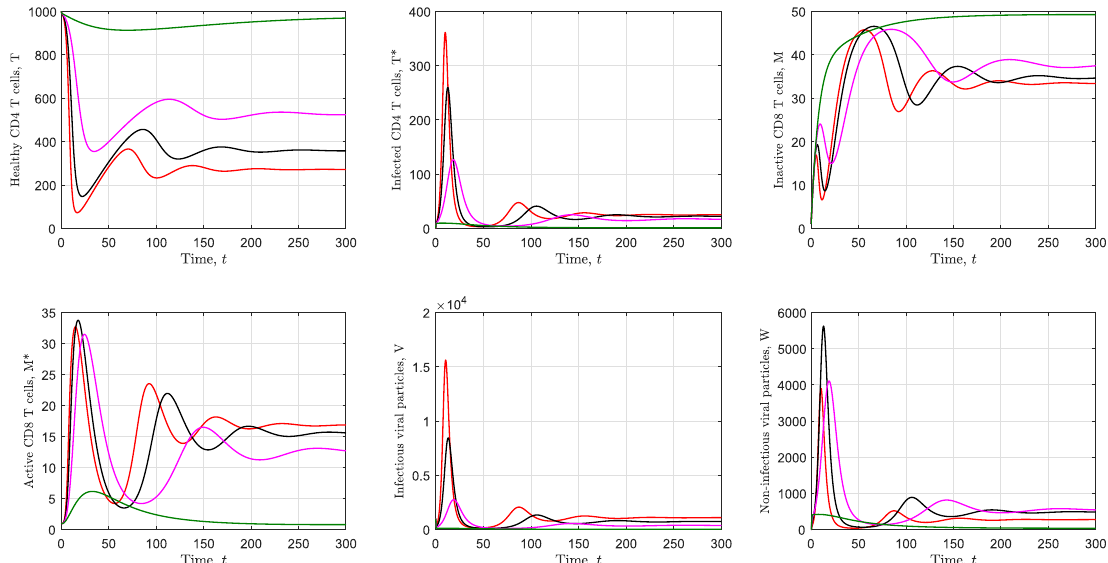
Figure 5. System simulation (7), taking the CD4 T cell infection probability, β = 2.5 × 10 − 5 , the probability of active CD8 T cells eliminating the infected CD4 T cells, γ = 2 × 10 − 3 and use of RTI is not considered, u 1 = 0. The PI are varied, u 2 = ( 0.2,0.4,0.6,0.8 ) that correspond to the colored curves (red, black, magenta, and green) with their respective values of R 0 = ( 1.6224,1.3168,1.0112,0.7056 ) in a simulation time of t = 300